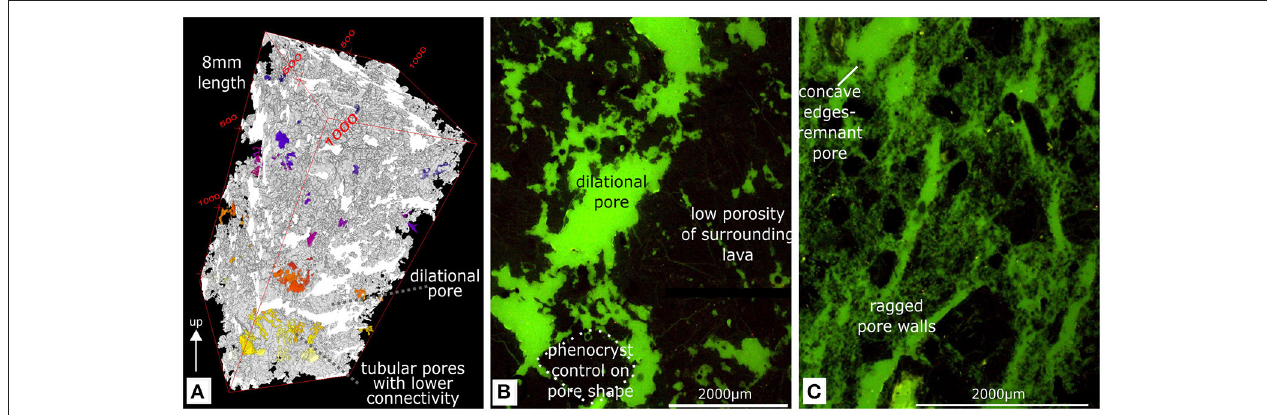
FIGURE 7 | (A) Tomography of pores in a vesicular zone bordering a spine. The 100 largest pores are displayed in the image in different colors. Note the high connectivity of dilational pores (white) and zone of lower porosity with lower connectivity (bottom corner). (B) UV photo of flow band in a spine showing interconnected dilational pores and phenocryst control on pore shape. Most pore walls are concave and convex in this example. (C) UV photo of a shear zone with ragged pore walls marked by the protrusion of groundmass fragments and phenocrysts. Remnant concave pore walls of previous pores are also visible. Note subvertical alignment of pores.